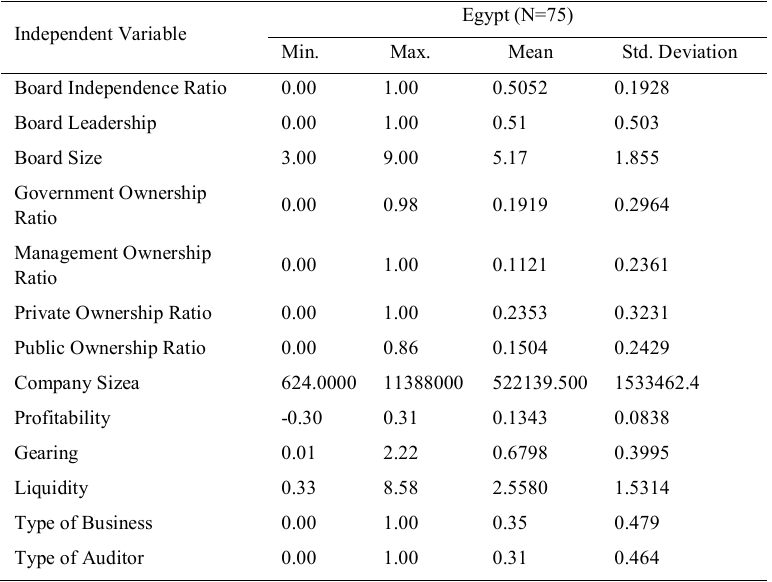
Table 2: Summary of Descriptive Statistics for Independent